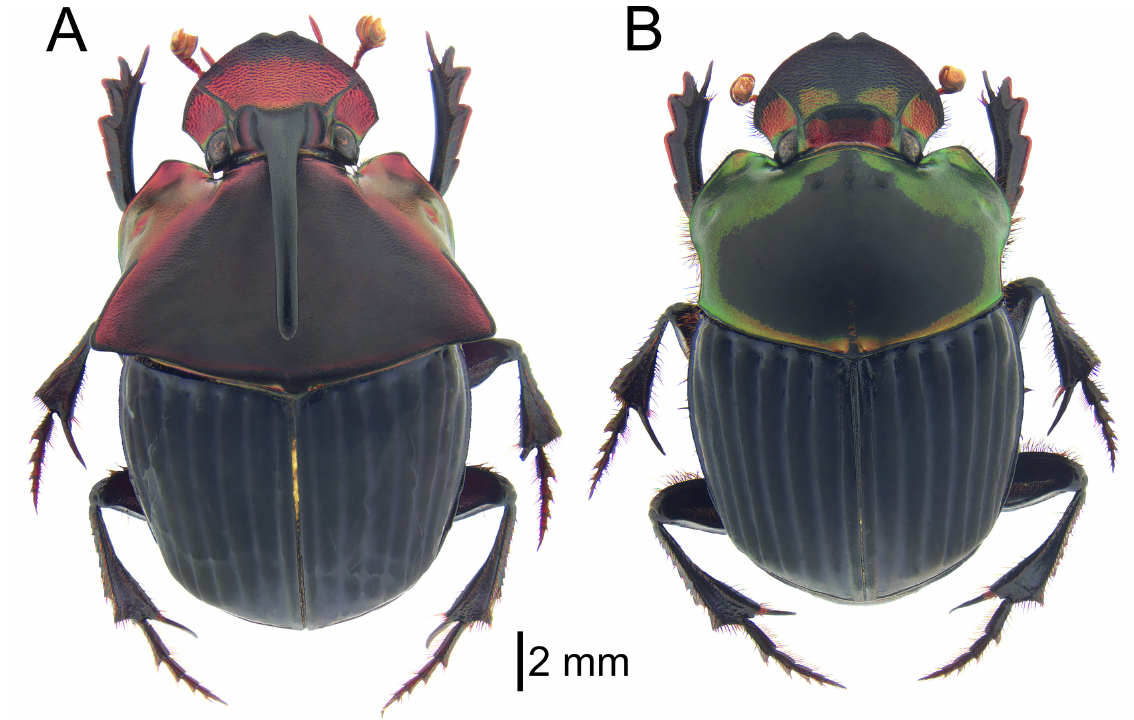
Fig. 10. Phanaeus panamensis sp. nov. A . Holotype, ♂ (TAMU). B . ♀